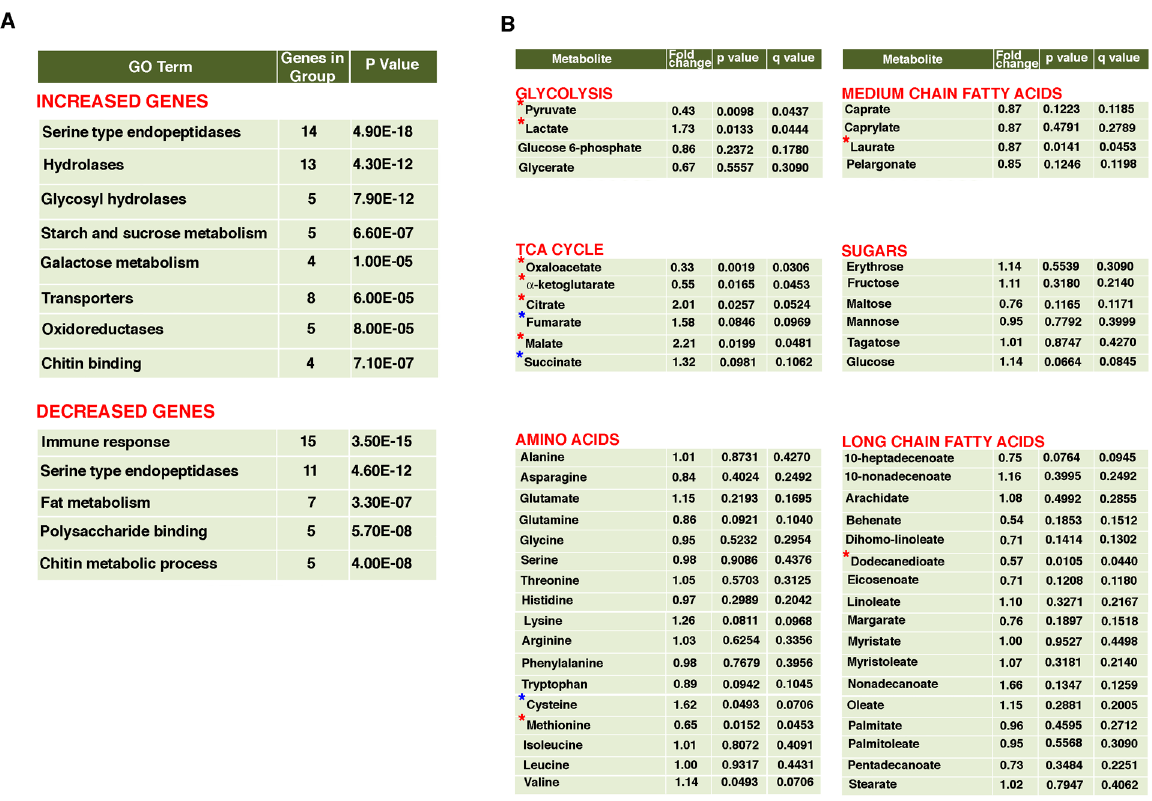
Figure 1. Metabolic reprogramming in dcerk 1 mutants. A. Functional classification of genes whose expression is altered in dcerk 1 mutants compared to control w 1118 flies. RNA extracted from control and mutant flies was hybridized to Affymetrix Drosophila 2.0 microarrays and experiments were carried out in triplicate. Gene expression analysis revealed 152 genes were increased (2-fold or more) and 158 genes were decreased (0.5 fold or less) in dcerk 1 compared to w 1118 . DAVID gene functional annotation tool and functional classification tool were used to annotate and classify the increased and decreased genes into functionally related gene groups. The top GO terms obtained for increased and decreased genes are listed along with the number of genes altered in each category and the statistical significance based on modified Fisher Exact P- Value. Serine type endopeptidases and hydrolases are upregulated while immune response genes are downregulated in the mutant. B. Metabolomic profiling reveals changes in glycolysis and TCA cycle metabolites in dcerk 1 compared to w 1118 . Control and mutant fly extracts were subjected in triplicate to GC/MS, LC/MS and LC/MS/MS platforms to compare relative levels of several metabolites. The fold change, dcerk 1 / w 1118 is shown for each metabolite. A p value of , 0.05 and a q value of , 0.1 (false discovery rate) is considered highly statistically significant (marked by a red *). Among glycolysis intermediates, pyruvate and lactate meet these stringent criteria; pyruvate level is decreased while lactate level is increased in the mutant. Among TCA cycle metabolites, oxaloacetate and a -ketoglutarate are decreased while citrate and malate are increased. Fumarate and succinate are also increased and meet the less stringent statistical criteria of approaching significance (p 0.05 2 0.1 and q 0.1 or less, marked by a blue *). Most amino acids (other than cysteine and methionine) and sugars do not show significant differences. Among fatty acids, Dodecanedioate, a long chain fatty acid is decreased significantly in the mutant. This could be due to its degradation to acetyl CoA and succinate, the latter being important for gluconeogenesis during